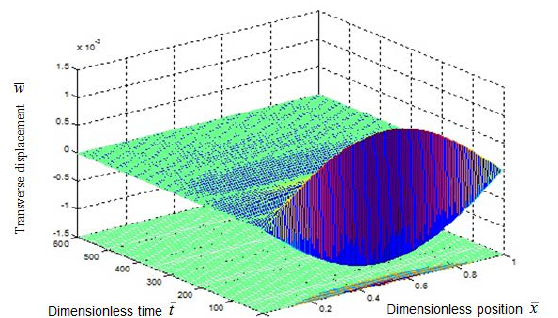
Figure 12. Dynamic response of the transverse displacement profile for the case R i = 0 . 41 m,γ = 0 . 02 ,n = 1 ,δ 0 . 3721 , ¯ U = 0 . 01 , Θ = 100 ◦ C,χ 1 = − 0 . 9